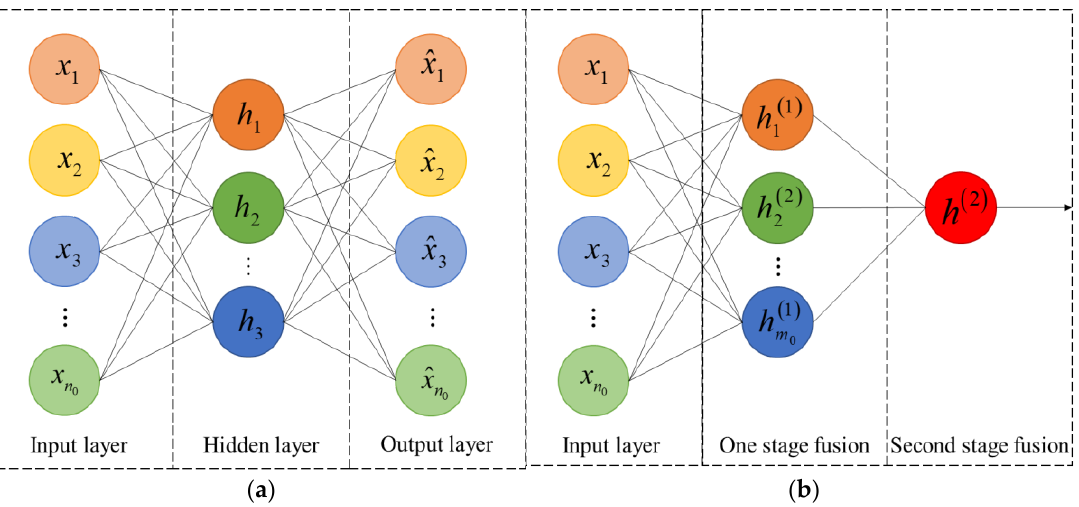
Figure 3. Schematic diagram of feature fusion by SAE: ( a ) SAE structure; ( b ) SAE fusion. The input and output of the network are x and ˆ x , hidden layer node output h j and output layer node ˆ x k can be defined by Equations (5) and (6):